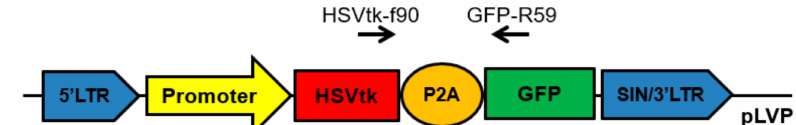
Figure 1. Scheme of the obtained lentiviral constructs developed for in vitro studies. Promoter: pCMV, pPCNA, or pIGFBP2. HSVtk: herpes simplex virus thymidine kinase gene. GFP: green fluorescent protein (CopGFP) gene used as a reporter gene. P2A: the DNA-sequence of P2A peptide of the